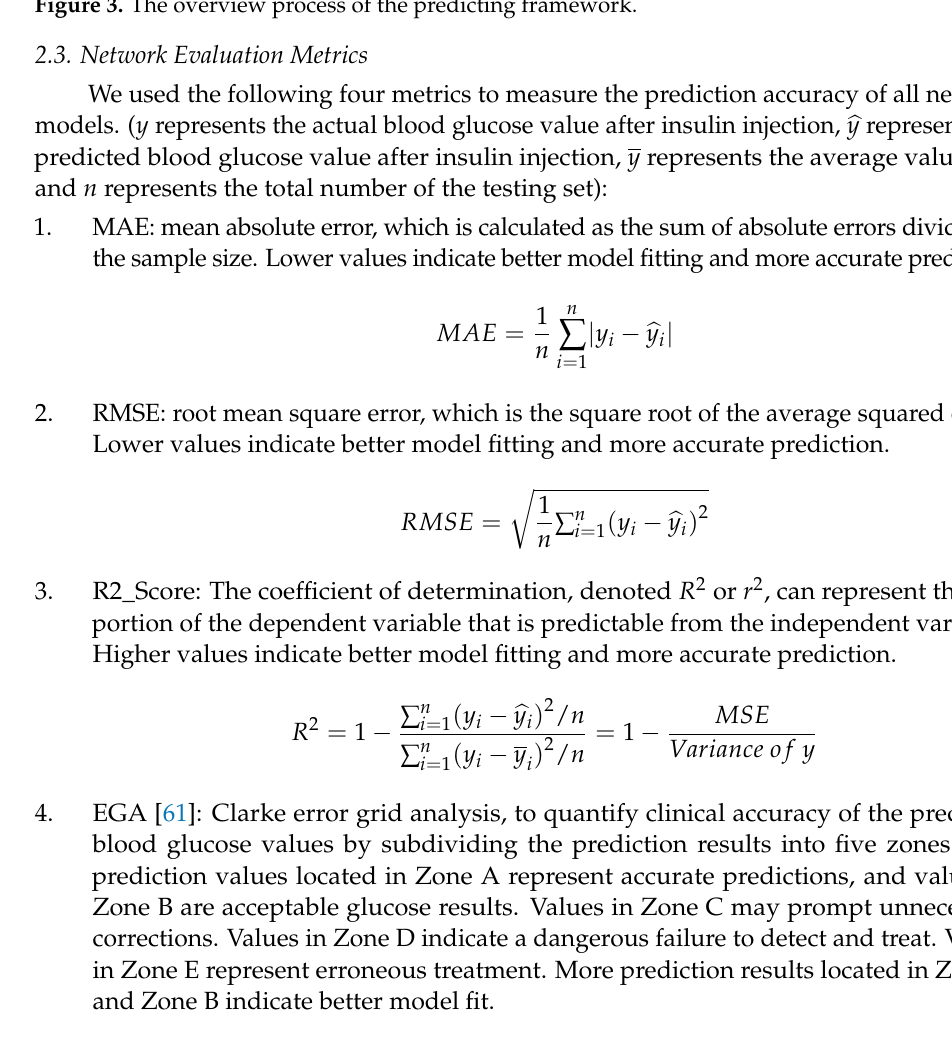
Figure 3. The overview process of the predicting